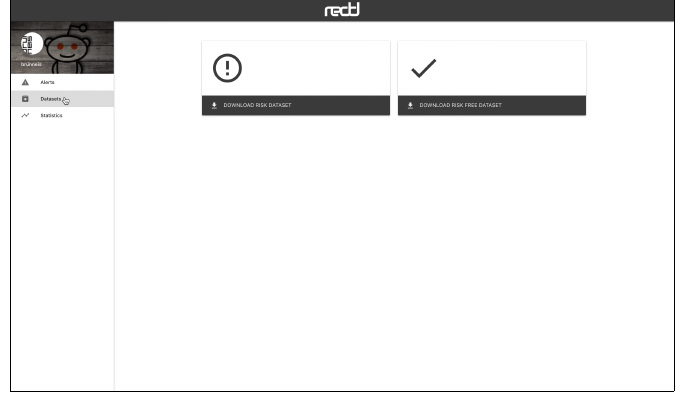
Figure 7. View to download the extracted dataset.